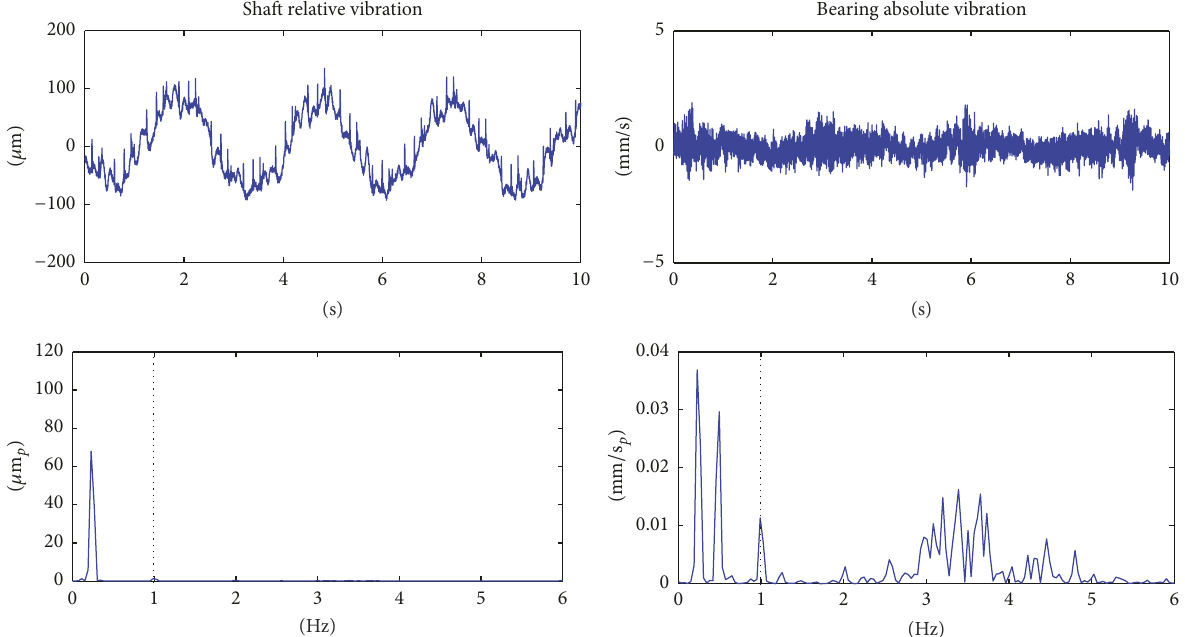
Figure10:Shaftrelativeandbearingabsolutevibrationsat X -directionoftheupperjournalbearing,withabalancedgeneratorrotoroperating with 320 MW.